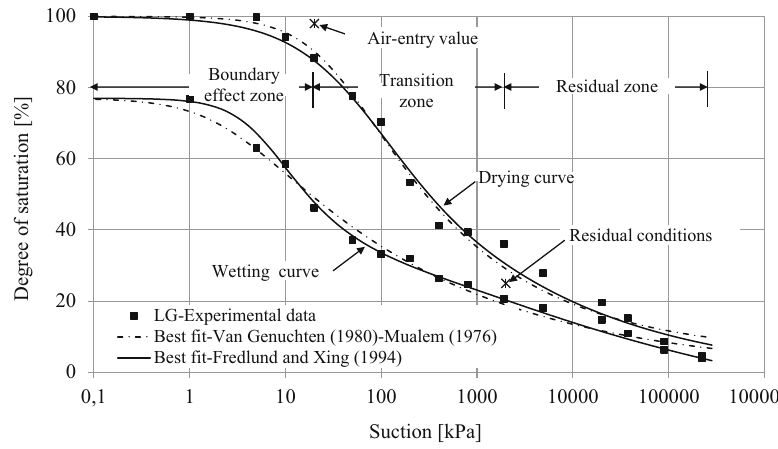
Figure 9: Soil – water characteristic curve ( SWCC ) , degree of saturation versus suction for LG soil.